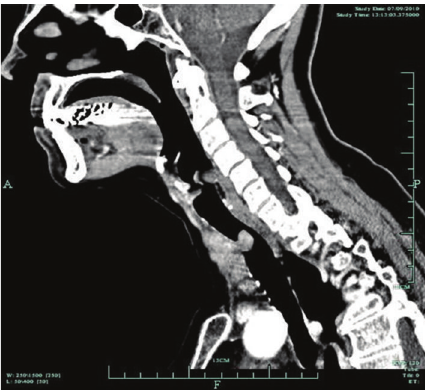
Figure 1: CT scan of the neck and mediastinum which revealed a mass originating from the thyroid gland, invading and severely obstructing the lumen of the trachea.